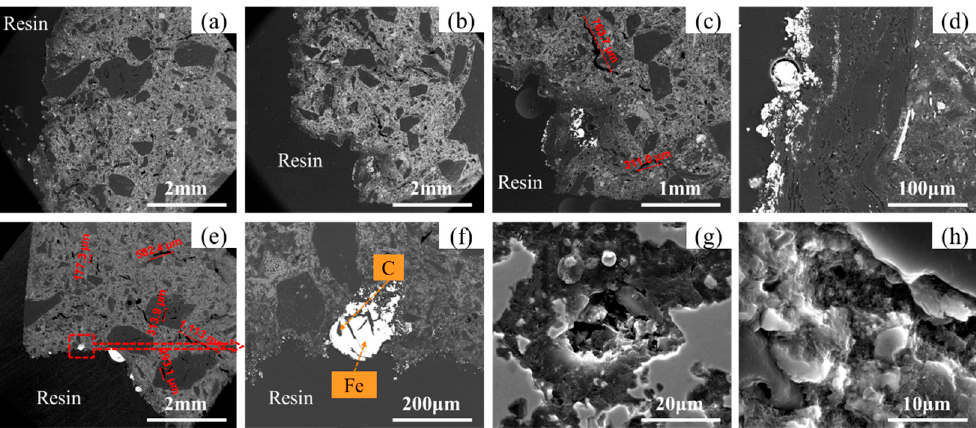
Figure 13. ( a – h ) Microscopic morphology of C after